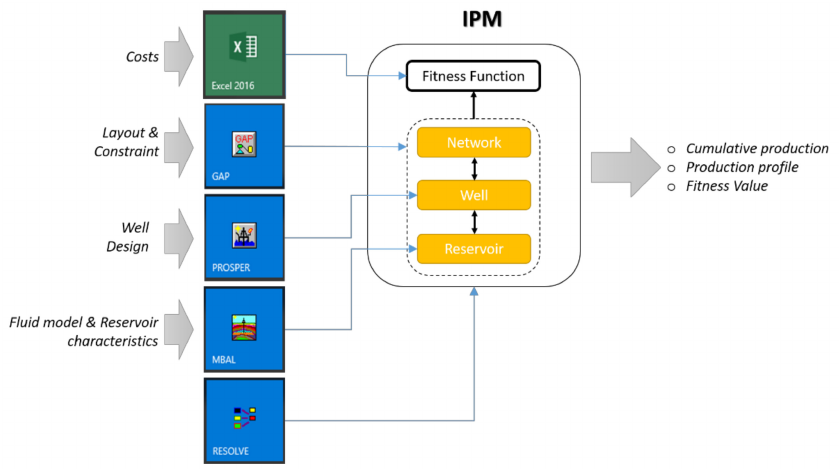
Figure 6. Integrated production model